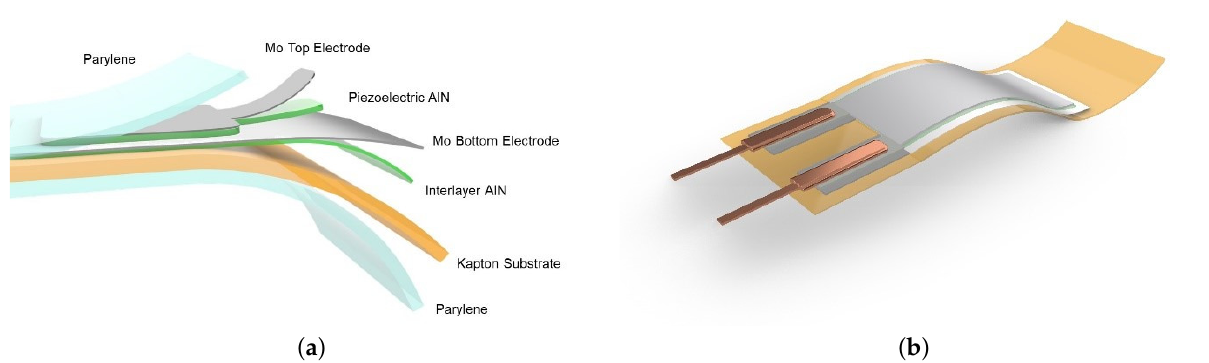
Figure 2. The flexible structure of the piezoelectric devices was optimized to guarantee high flexibility and sensitivity. In addition all the materials used for its fabrication are completely biocompatible, suitable for environmental use ( a ). The 3D sketch highlights the extremely compactness of the transducer ( b